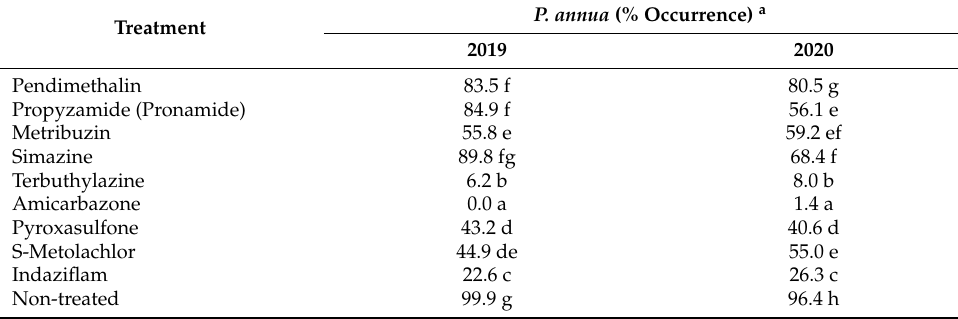
Table 6. Effect of autumn herbicide treatments on % occurrence of P. annua in golf turf in 2019 and 2020 after 28